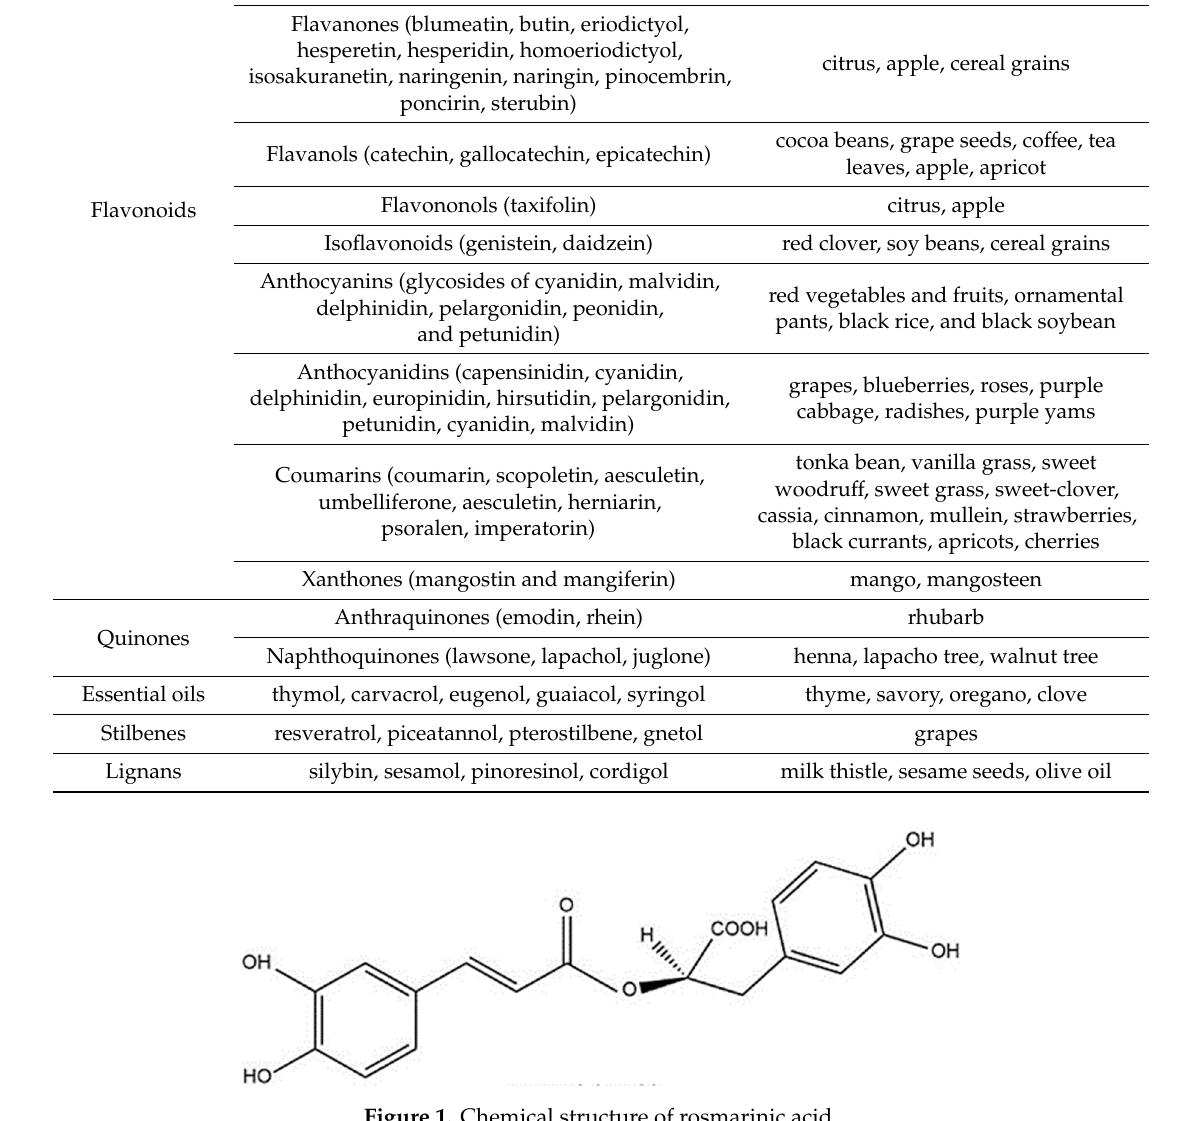
Figure 1. Chemical structure of rosmarinic acid.